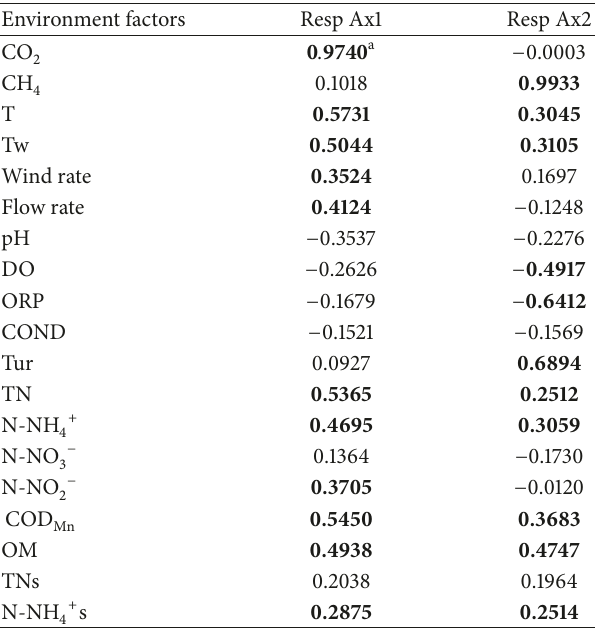
Table8:Correlationcoefficientsamongenvironmentalfactors,flux, and RDA ordination axes.